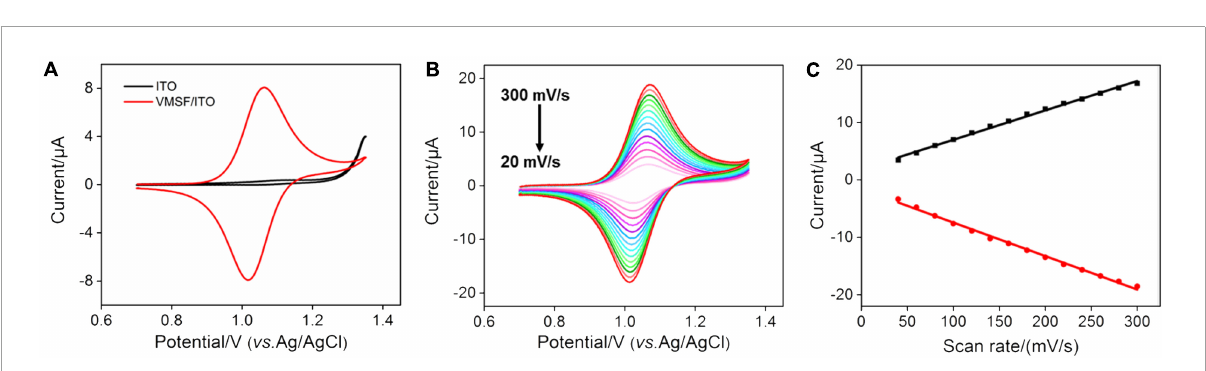
FIGURE2 (A) CV curves obtained at the bare ITO (black line) and VMSF/ITO (red line) electrodes in 0.1 M PBS (pH 7.0) containing 1 µ M Ru(bpy) 32 + . The scan rate was 100 mV/s. (B) CV curves of the VMSF/ITO electrode in 0.1 M PBS (pH 7.0) containing 1 µ M Ru(bpy) 32 + at different scan rates. (C) The relationship between redox peak currents and scan